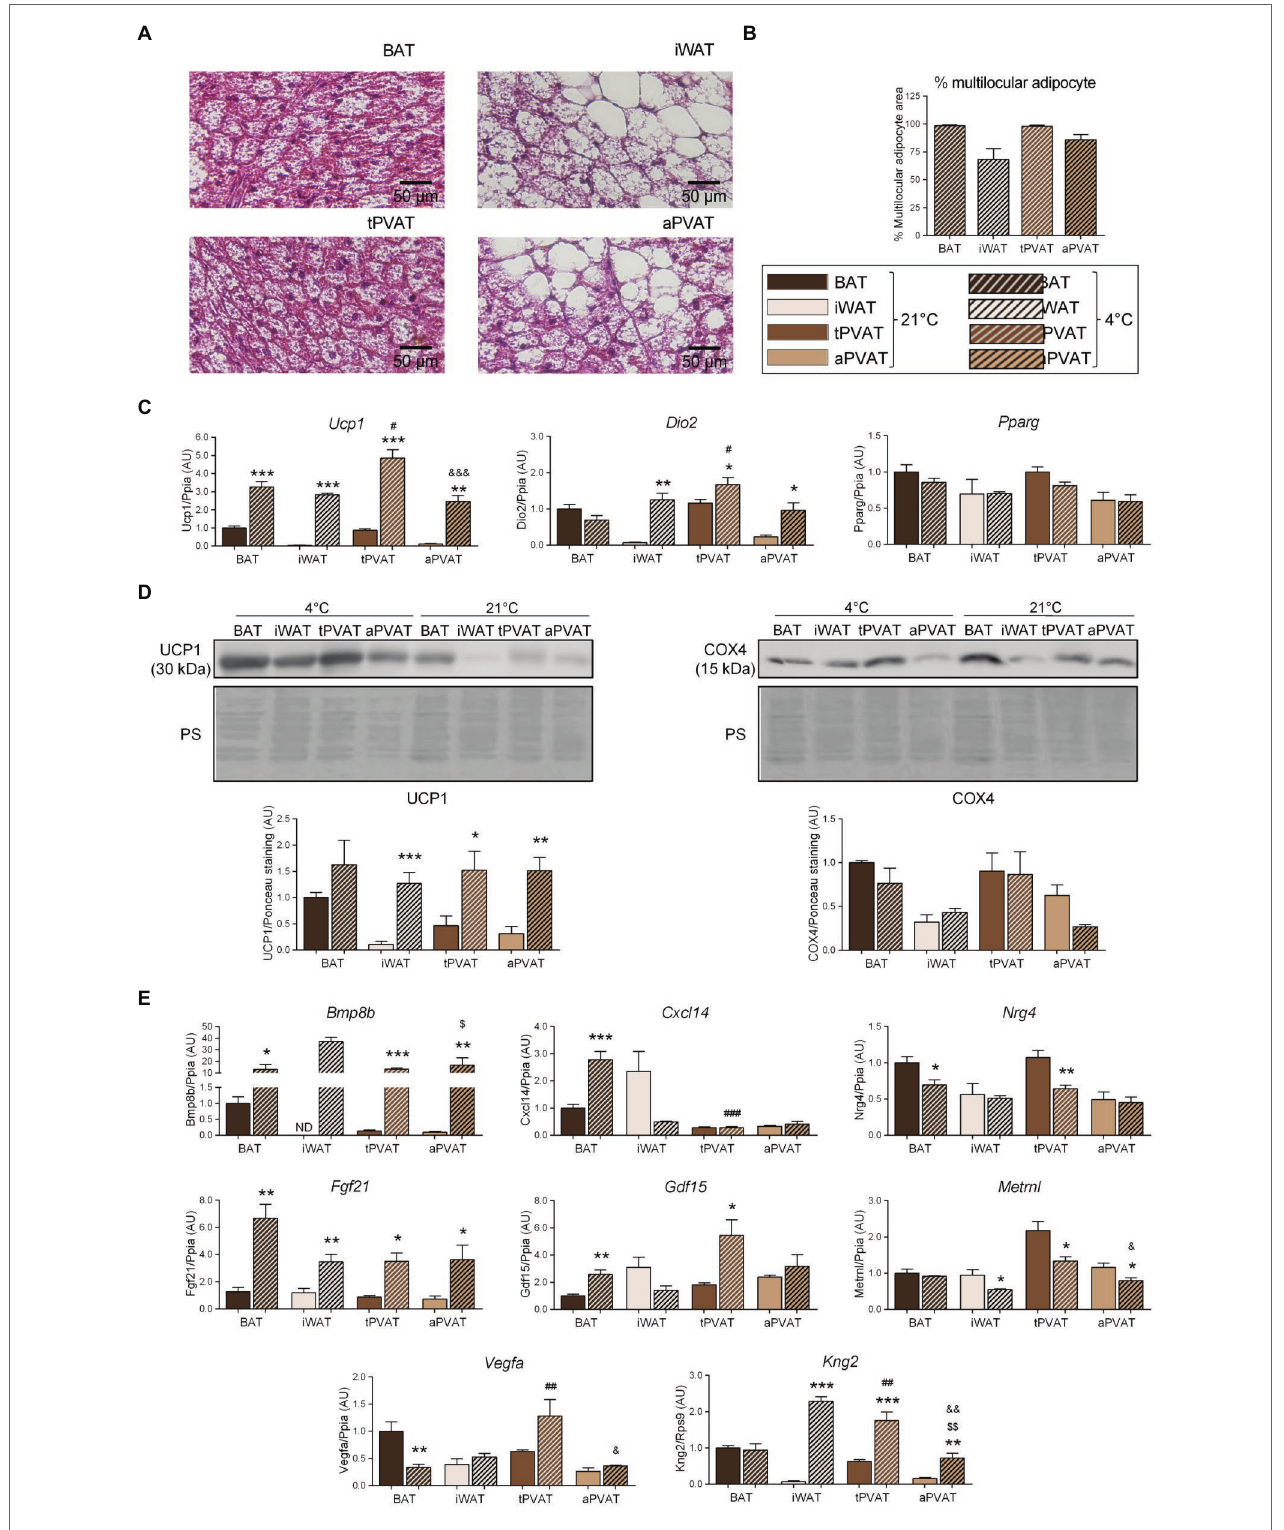
FIGURE 2 | Effects of 1-week cold (4 ° C) exposure on perivascular adipose depots in mice. (A) Representative optical microscopic pictures of hematoxylin-eosin stained sections of adipose tissue samples. (B) Quantitative assessment of cell morphology in adipose tissue depots. (C) Relative transcript levels of genes encoding